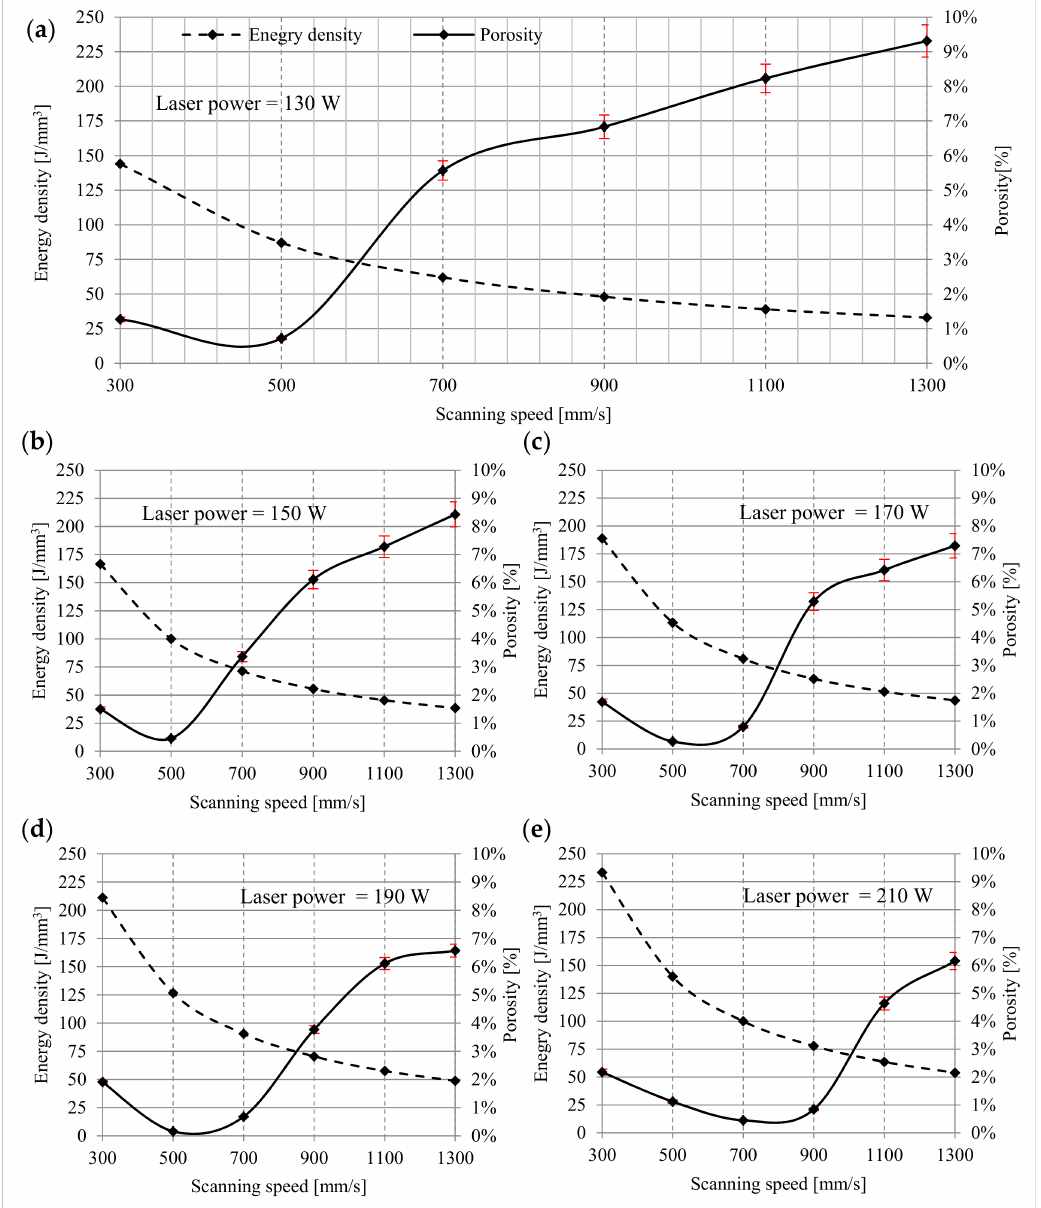
Figure 3. The influence of scanning speed and energy density on the porosity: ( a ) 130 W, ( b ) 150 W, ( c ) 170 W, ( d ) 190 W, ( e ) 210